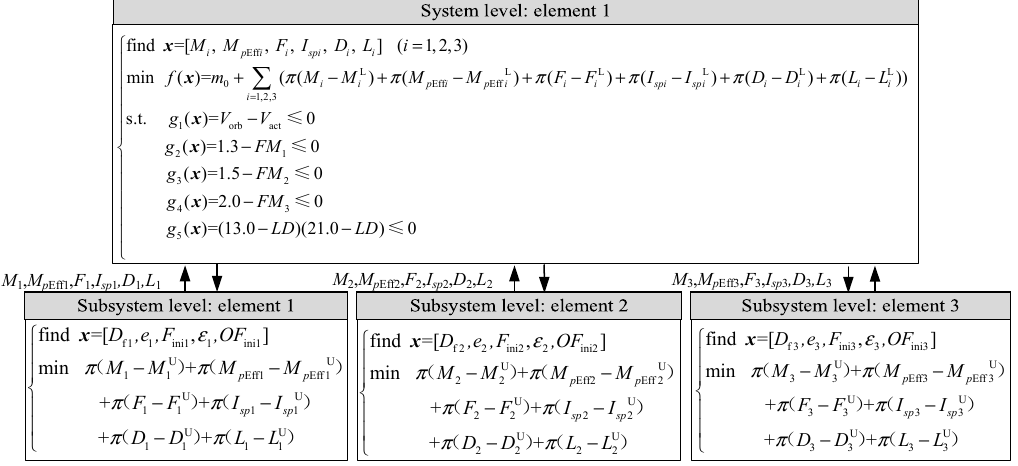
Figure 12. ATC mathematical models at different levels.